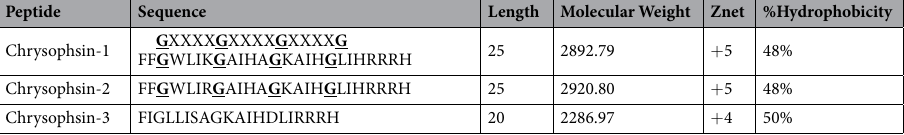
Table 1. Amino Acid Sequences of three different isoforms of Chrysophsin; Glycine residues of the identified GXXXXG motifs are marked in bold and underlined.